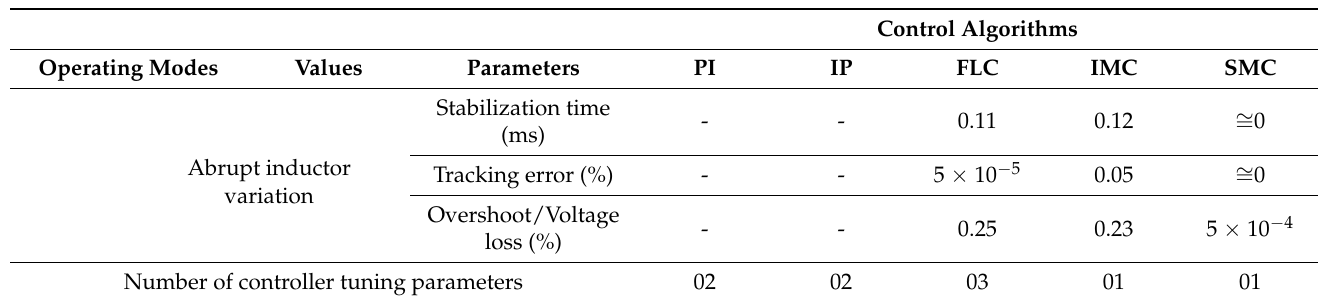
Figure 8. Target output voltage variation: ( a ) evolution of the control voltage and ( b ) evolution of the output voltages.